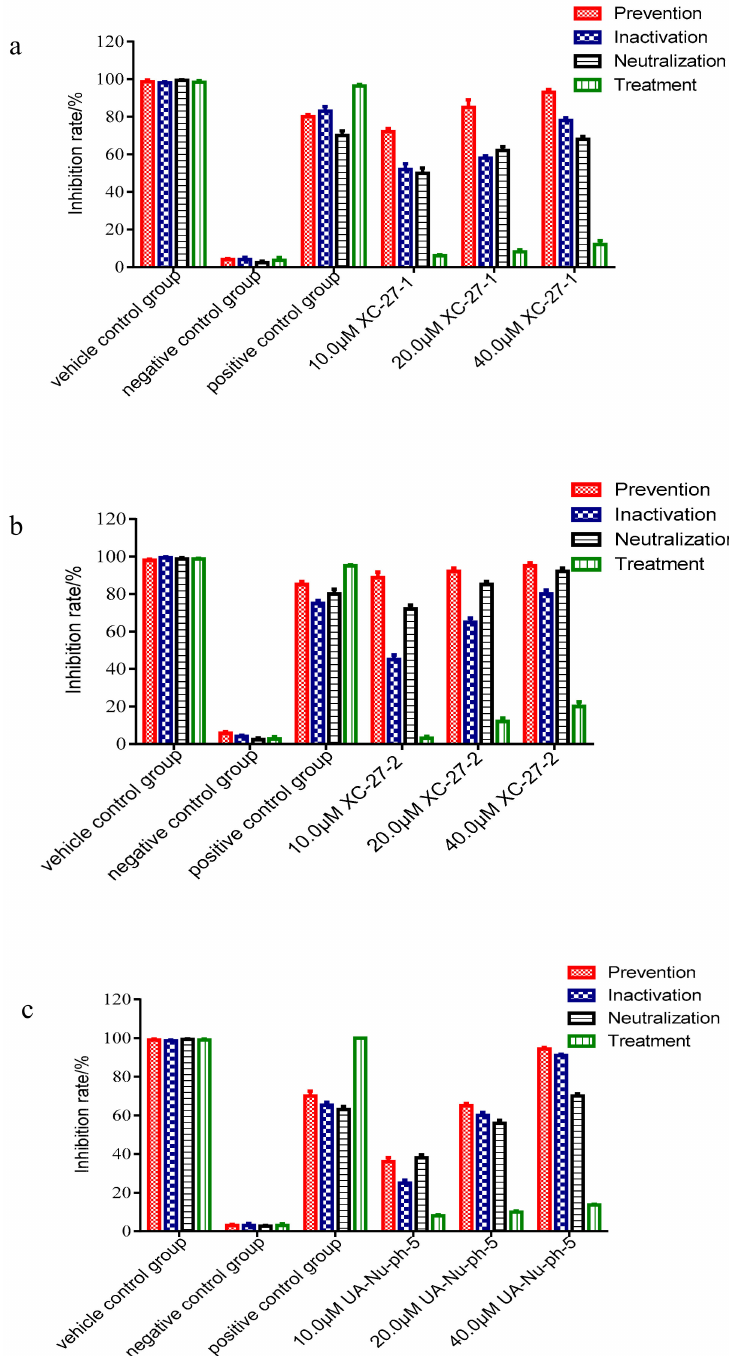
Figure 5. The inhibition rate of derivatives for the H5N1 viral plaques forming amounts. ( a – c ) respectively represent the average inhibition rate of XC-27-1, XC-27-2, and UA-Nu-ph-5 for H5N1 viral plaque-forming units (PFUs). Each group was investigated in triplicate for each experiment. Data pooled from three independent experiments ( n = 3, mean ±